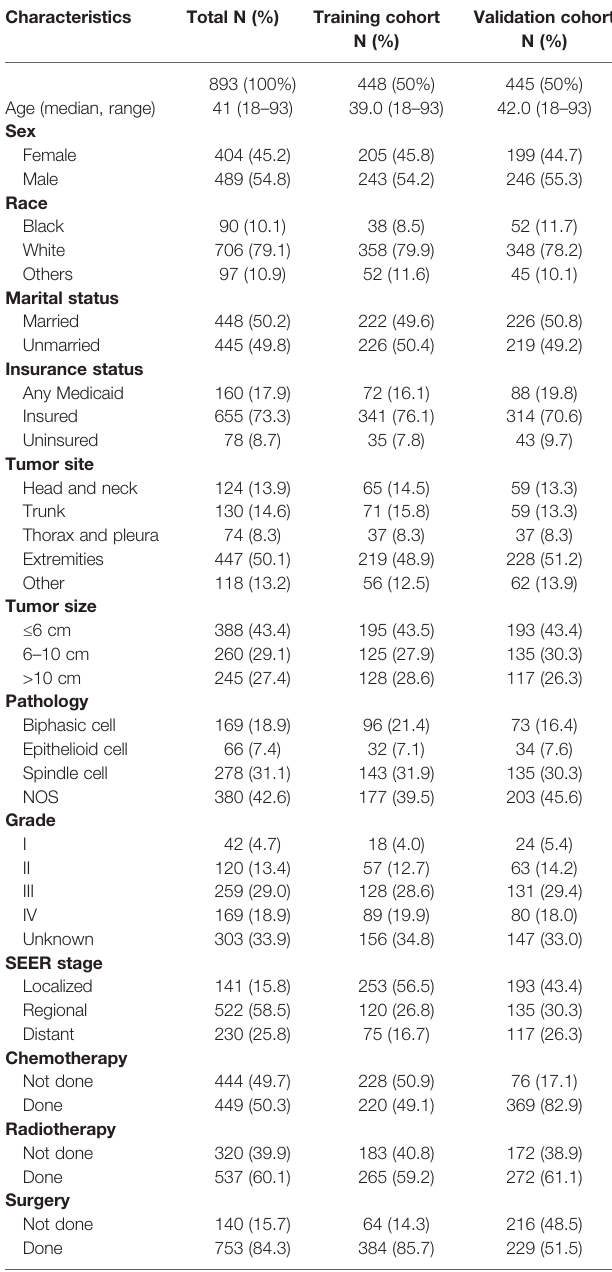
TABLE 1 | Patient characteristics in the training and validation cohorts.